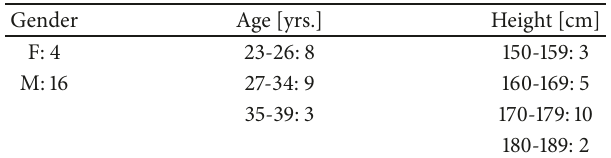
Figure 5: Wearable smart IoT device. Table 3: Performance metrics of IoT device.